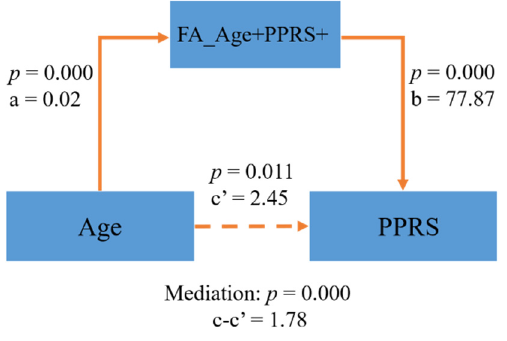
Figure 4. FA_Age+PPRS+ partly mediated the relationship of Age → PPRS.